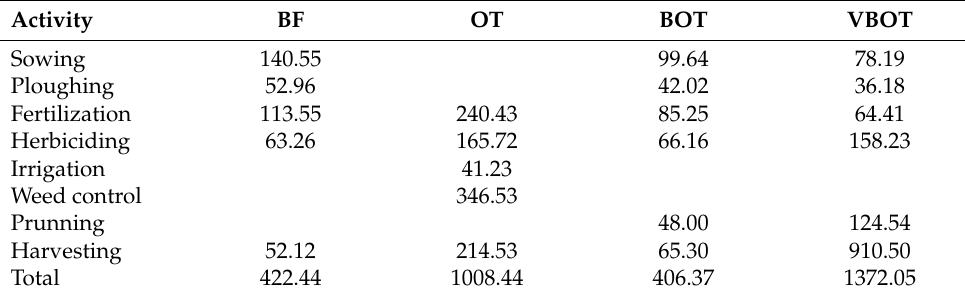
Table 4. Economic analysis for each activity on the